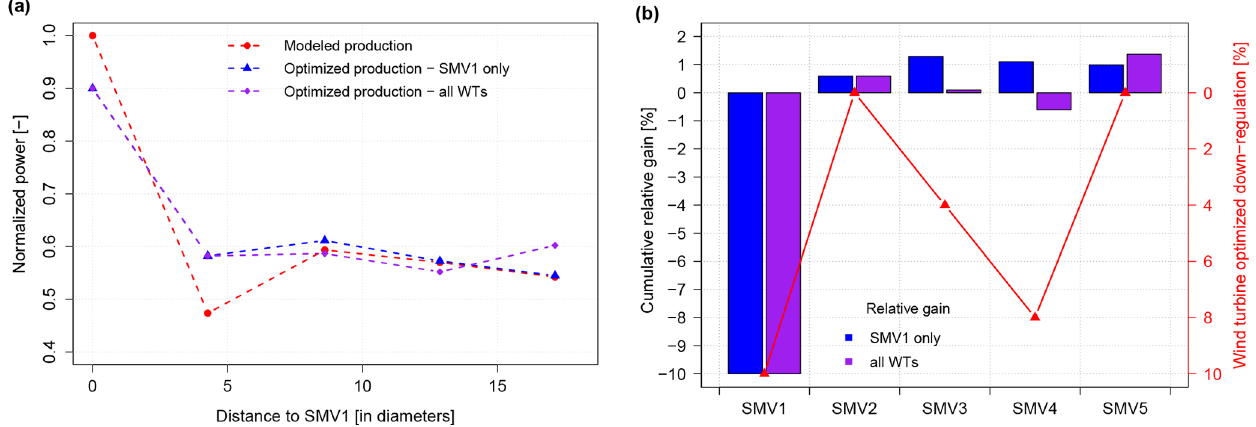
Figure 13. Variation of normalized power at each wind turbine (a) , cumulative relative gain and optimized down-regulation settings (b) along the row, for full wake conditions (wind direction of 5 ◦ at 8ms − 1